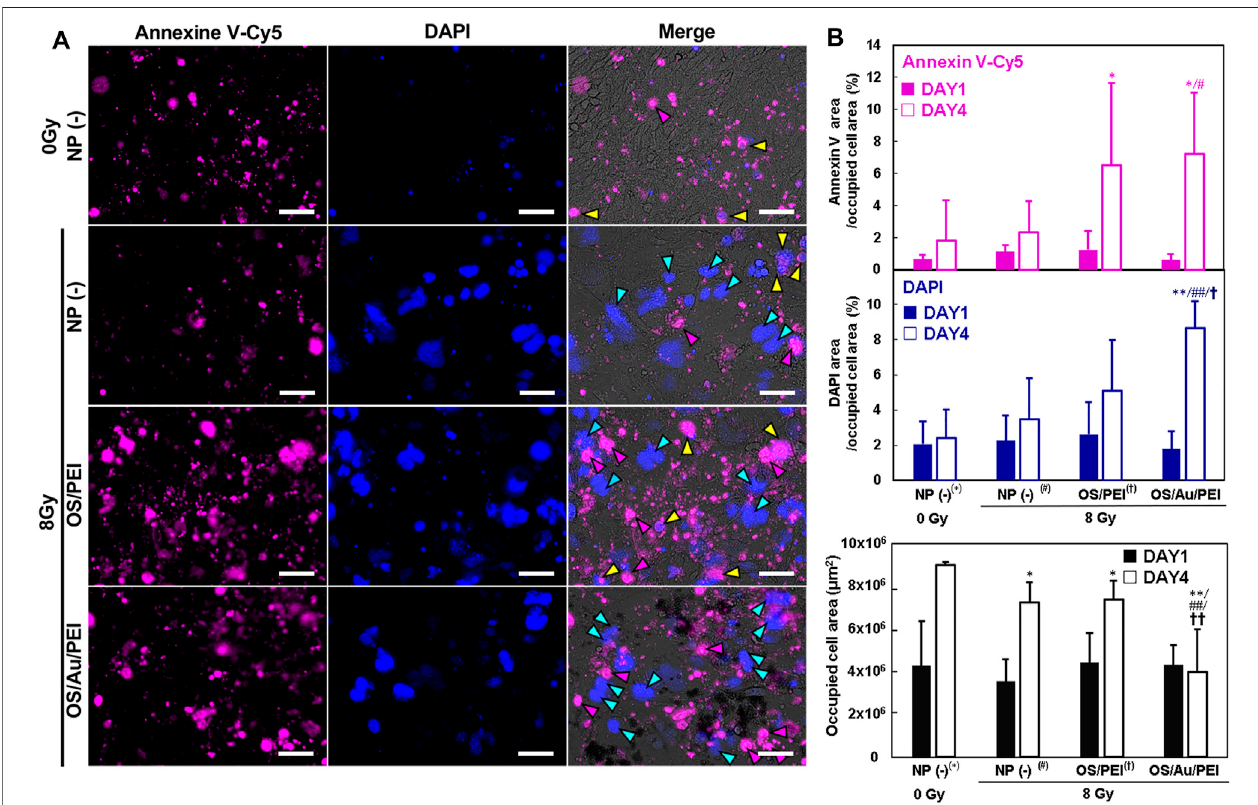
FIGURE 7 | (A) FM image of 4T1 cells for apoptotic and necrotic cell determination by Annexin V/DAPI staining treated with 30 μ g ml − 1 of NP (-), OS, OS/PEI, and OS/Au/PEI with X-ray irradiation after DAY4. Scale bar = 50 μ m. (B) The FM image analysis of 4T1 cells for apoptotic and necrotic cell determination by Annexin V/DAPI stainingtreatedwith30 μ g ml − 1 of NP(-), OS, OS/PEI, and OS/Au/PEI with X-ray irradiation after DAY1 and DAY4. *Signi fi cantlydifferentfrom the4T1 cells treated with 0 Gy NP (-). # Signi fi cantly different from the 4T1 cells treated with 8 Gy NP (-). † Signi fi cantly different from the 4T1 cells treated with 8 Gy OS/PEI.